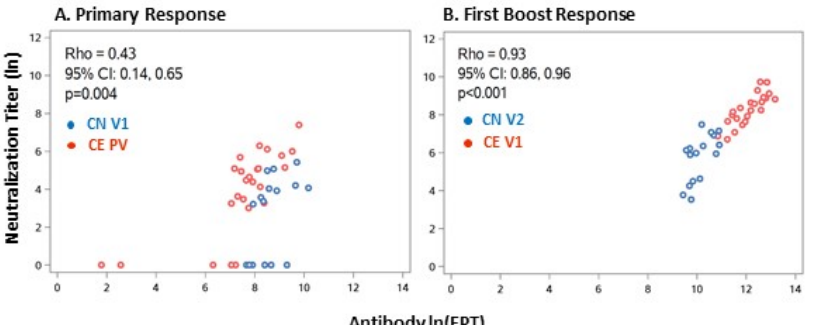
Figure 5. Comparison of antibody EPT and neutralization titer. ( A ) Primary response. ( B ) First boost response. Natural log of antibody EPT ( x -axis) graphed against natural log of NT ( y -axis). Spearman’s rank correlation coefficient with 95% confidence interval for antibody EPT and NT was calculated in the overall sample at each response time-point.